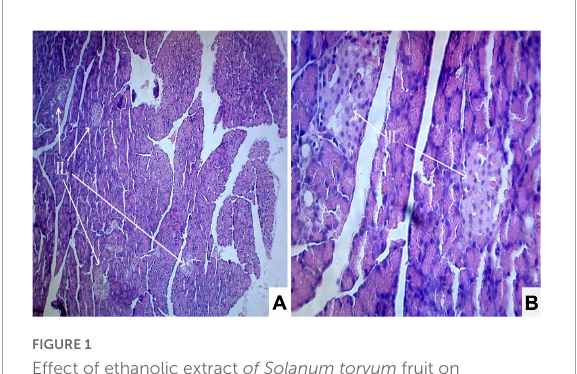
FIGURE1 Effect of ethanolic extract of Solanum torvum fruit on histopathology of pancreas in streptozotocin (STZ) induced diabetic Sprague–Dawley rats (SD rats). (A,B) Photomicrograph of a section from pancreas (Normal control group) showed normal architecture. The acinar cells are seen to be normal. (A) H & E 10X; (B) H & E 40X. IL, islets of Langerhans cells.